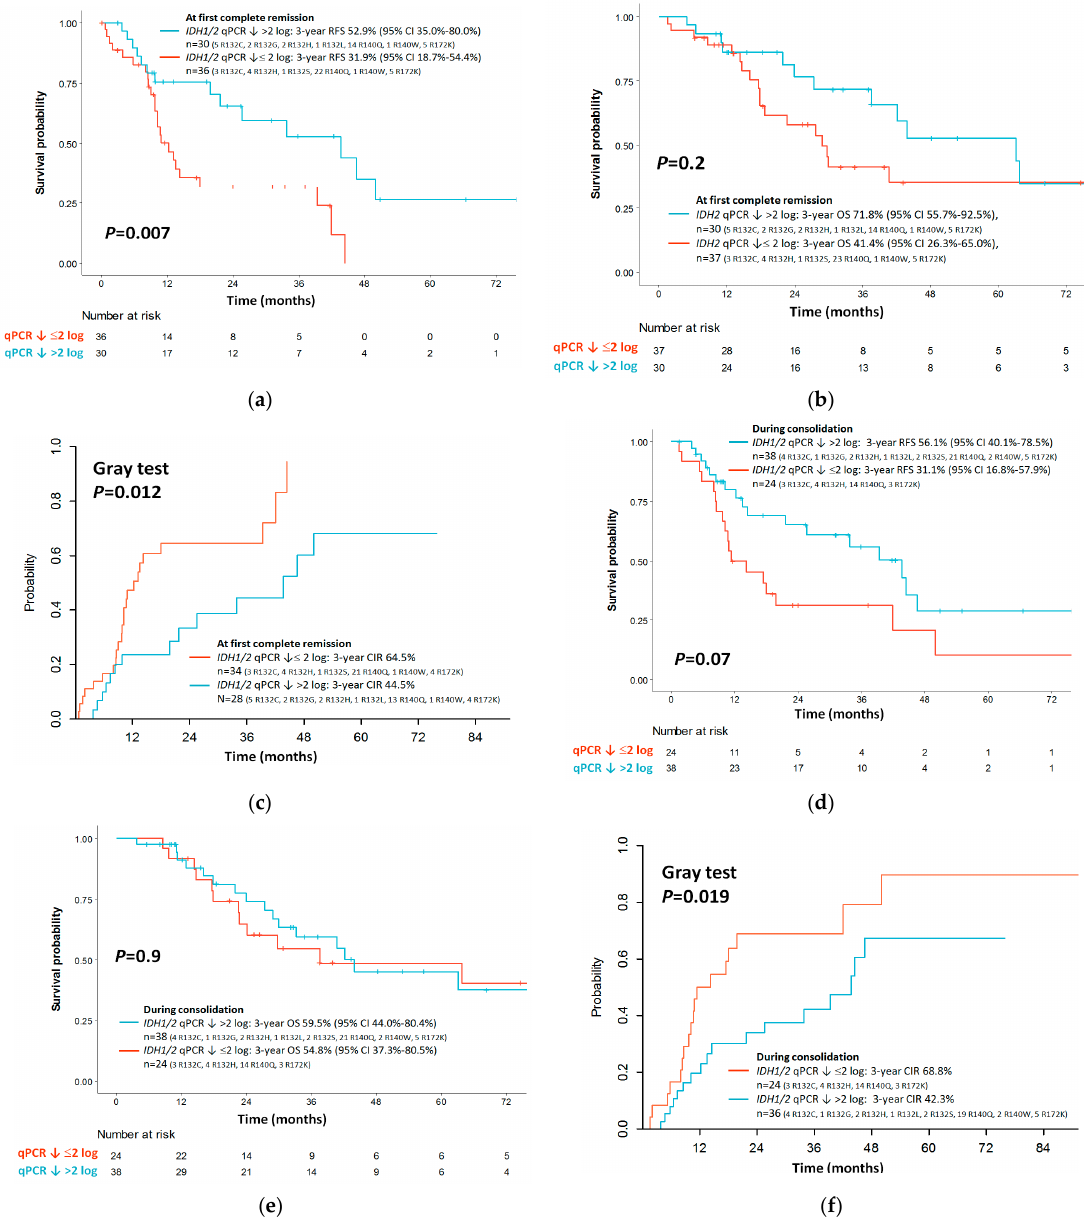
Figure 6. The relapse ‐ free survival ( a ), overall survival ( b ), and cumulative incidence of relapse ( c ) of AML patients based on IDH1/2 LNA ‐ qPCR MRD at post ‐ induction of first complete remission. The relapse ‐ free survival ( d ), overall survival ( e ), and cumulative incidence of relapse ( f ) of AML patients based on IDH1/2 LNA ‐ qPCR MRD during consolidation therapy. Based on IDH1/2 mutation subtypes, IDH2 ‐ R140 post ‐ induction MRD ≤ 2 log reduction was associated with significantly inferior RFS (3 ‐ year RFS rates 24.2% [95% CI 11.0%–53.3%] vs. 48.0% [95% CI 24.6%–93.8%], p = 0.001) and higher CIR (3 ‐ year CIR rates 71.4% vs. 42.0%, p = 0.002) compared to post ‐ induction IDH2 ‐ R140 MRD > 2 log reduction (n = 38), while IDH1 ‐ R132 mutation (n = 18) or IDH2 ‐ R172 mutation (n = 8) MRD had no impact on RFS and CIR. 3.7. Outcome Impact of IDH1/2 LNA ‐ qPCR MRD during Consolidation For CR patients after one or two cycles of consolidation chemotherapy, we did not observe significant differences in RFS (3 ‐ year RFS 56.1% [95% CI 40.1%–78.5%] vs. 31.1% [95% CI 16.8%–57.9%], p = 0.07, Figure 6d) and OS (3 ‐ year OS 59.5% [95% CI 44.0%–80.4%] vs. 54.8% [95% CI 37.3%–80.5%], p = 0.9, Figure 6e) between patients with IDH1/2 LNA ‐ qPCR MRD > 2 log reduction and ≤ 2 log reduction. The CIR was significantly higher for patients with IDH1/2 LNA ‐ qPCR MRD ≤ 2 log reduction than patients with IDH1/2 LNA ‐ qPCR MRD > 2 log reduction (3 ‐ year CIR 68.8% vs. 42.3%, p = 0.019; Figure 6f) Based on IDH1/2 mutation subtypes, IDH2 ‐ R140 MRD ≤ 2 log reduction during consolidation was associated with a trend of inferior RFS (3 ‐ year RFS rates 26.8% [95% CI 10.9%–66.0%] vs. 44.2% [95% CI 24.7%–79.1%], p = 0.06) and a significantly higher CIR rate (3 ‐ year CIR rates 73.2% vs. 44.8%, p = 0.013) compared to IDH2 ‐ R140 MRD > 2 log reduction during consolidation (n = 37), while IDH1 ‐ R132 mutation (n = 17) or IDH2 ‐ R172 mutation (n = 8) had no impact on RFS and CIR. 4. Discussion Our cohort of 88 adult patients with IDH1/2 ‐ mutated AML showed that the concordance rate of IDH1/2 LNA ‐ qPCR MRD with remission status was 79.5%. There was a positive correlation (r s = 0.68) and a substantial agreement (81%, K = 0.74) between IDH1/2 LNA ‐ qPCR and NPM1 RT ‐ qPCR MRD. The median difference in MRD results was 2 logs between IDH1/2 LNA ‐ qPCR and NPM1 RT ‐ qPCR. Patients with FLT3 mutation or younger age have a higher concordance rate between IDH1/2 LNA ‐ qPCR MRD, remission status, or NPM1 RT ‐ qPCR MRD. At the end of induction and during consolidation, IDH1/2 LNA ‐ qPCR MRD had a significant impact on CIR or RFS. Because of the single nucleotide substitution of IDH1/2 mutations, the sensitivity and specificity of IDH1/2 ‐ directed MRD are limited if there is a small proportion of IDH1/2 mutations in the wild ‐ type background. IDH1/2 ‐ targeted MRD using ddPCR assays